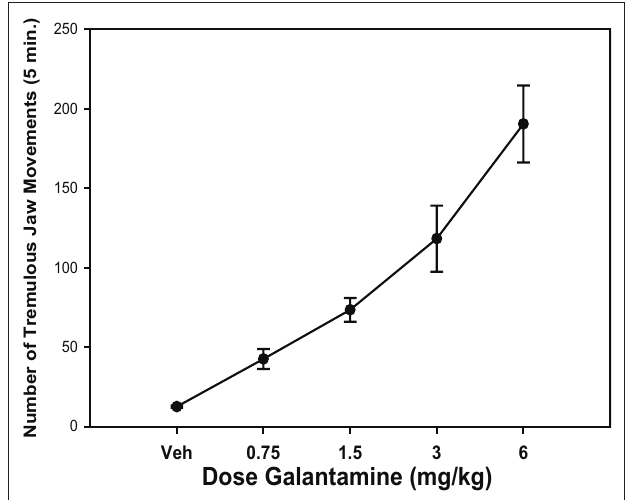
Figure 1 | effects of different iP doses of the anticholinesterase galantamine on tremulous jaw movements (Collins et al., 2011). Mean ( ± SEM) number of jaw movements (per 5 min) in rats ( n = 8) treated with either saline vehicle (Veh) or galantamine. Using a within-groups design, all rats received all drug treatments in a randomly varied order (one treatment per week). Rats were observed in three 5-min periods 10–25 min after injection. Repeated measures ANOVA revealed that galantamine produced a significant increase in tremulous jaw movement activity [ F (4,28) = 25.8; p < 0.001]. *Significant difference from vehicle control ( p